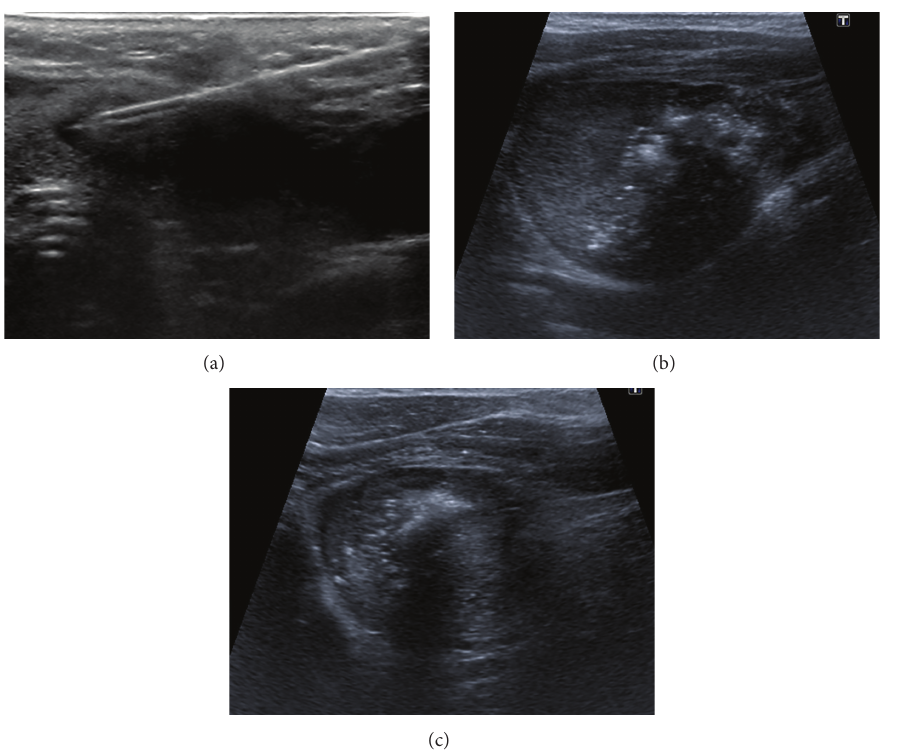
Figure 1: (a) Transverse US image shows the transisthmic approach. The probe, whose active part is placed in the nodule through its isthmus, is inserted from the medial to the lateral part of the nodule and is visible along its longitudinal axis. (b-c) Transverse US images show the moving-shot technique. RFA is performed unit by unit, aiming at ablating all the subunits of the nodule, which turn into microbubbles (hyperechoic areas with posterior barrage of the ultrasound beam). Initially, (a) the probe tip is positioned in the medial and deepest part of the nodule and subsequently (b-c) in its most superficial and lateral